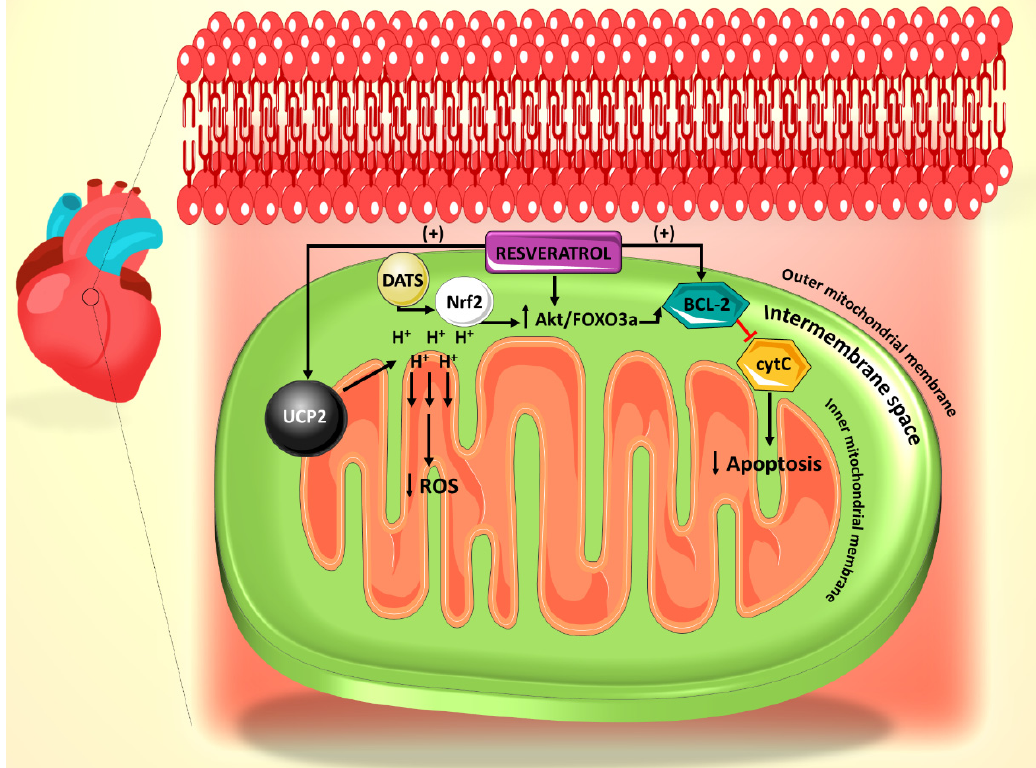
Figure 1. Summary of the effect of resveratrol on the mitochondrial reactive oxygen species (ROS) generation and apoptosis pathways. Resveratrol action is primarily mediated through UCP2 and Bcl-2. Diallyl trisulfide (DATS) is another polyphenol derived from garlic, which mediates its anti-apoptotic effect through Nrf2.